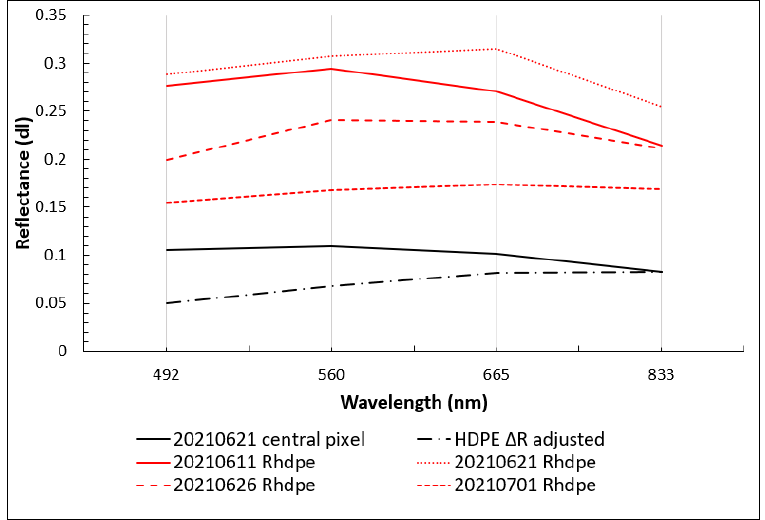
Figure 6. Four-band (RGB and NIR) spectral plots for 20210621 central pixel, 20210621 central pixel with water subtraction and unmixed signatures for the four first